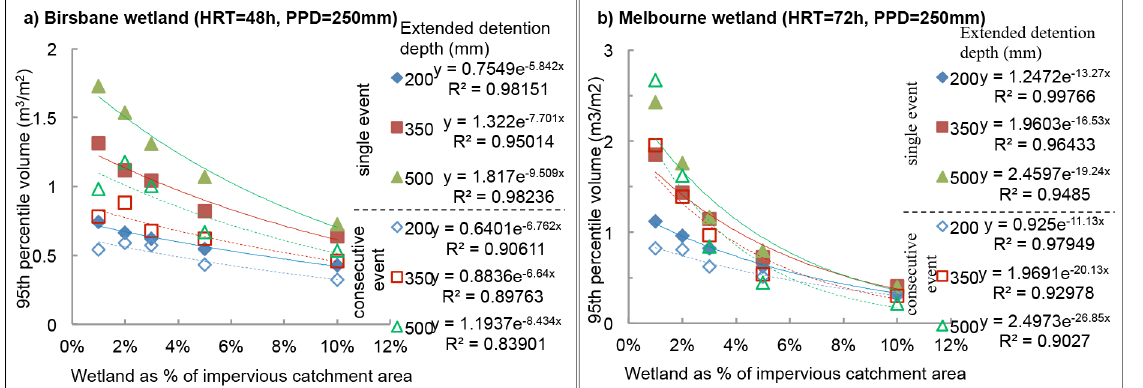
Fig 4. Plot of volume of water treated per unit area of wetland as a function of wetland area as percent of impervious catchment for: a) Brisbane wetland at the designed hydraulic resident time (HRT = 48 h) and permanent pool depth (PPD = 250 mm), and b) Melbourne wetland at the designed hydraulic resident time (HRT = 72 h) and permanent pool depth (PPD = 250